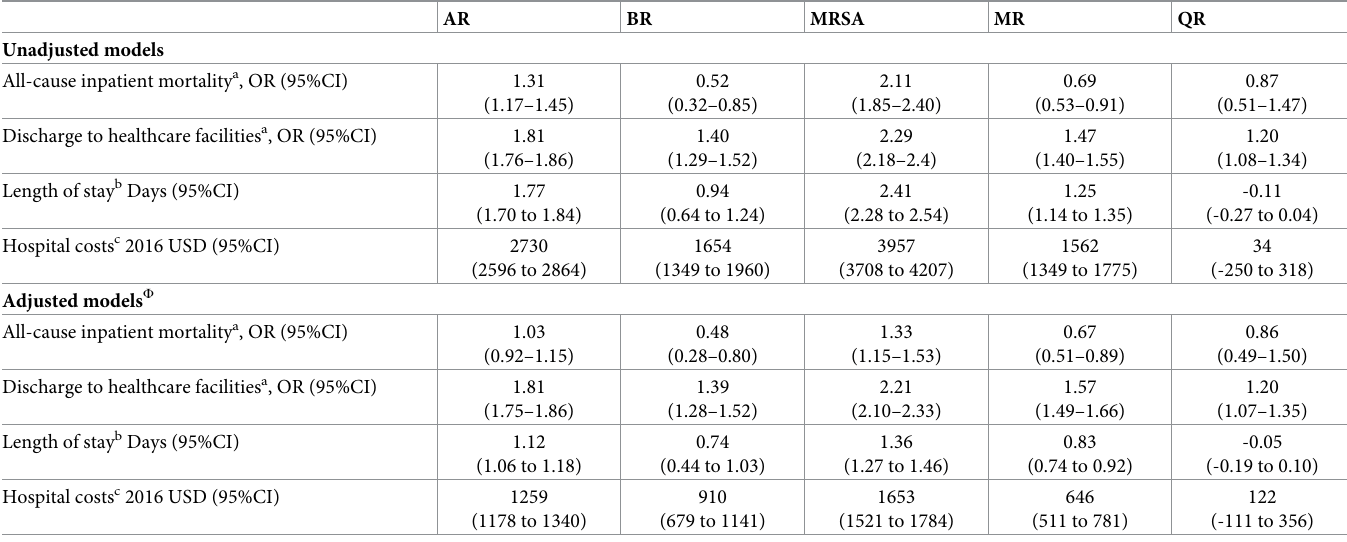
Table 2. Impact of antimicrobial